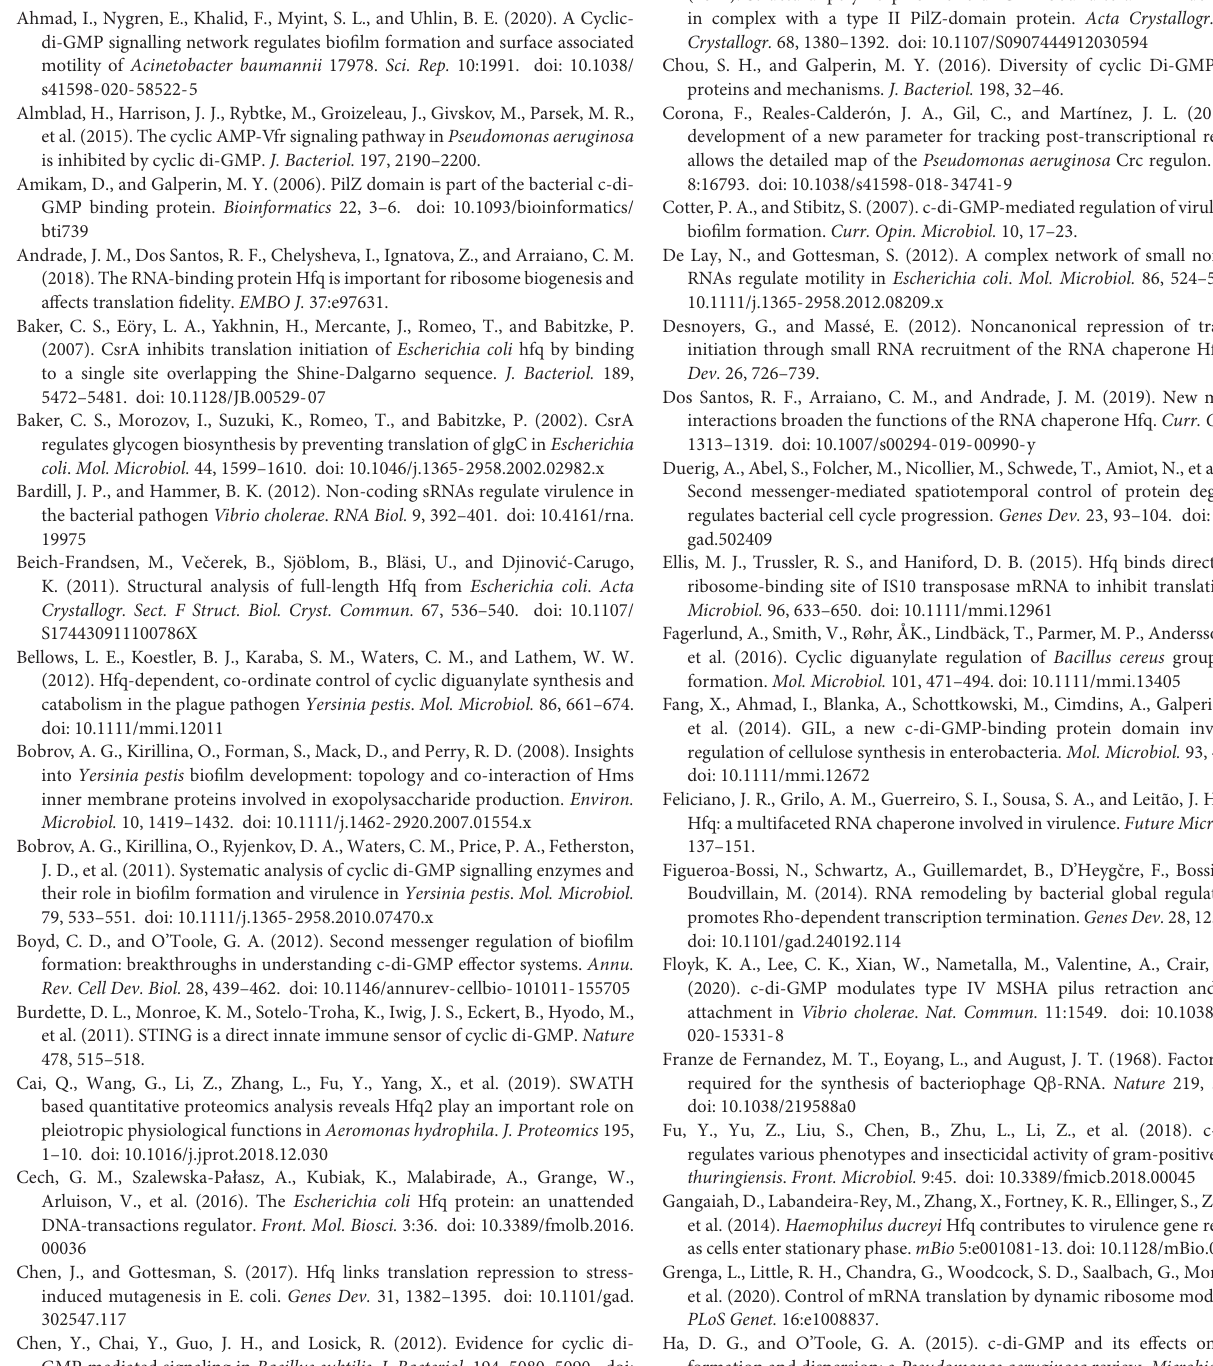
Figueroa-Bossi, N., Schwartz, A., Guillemardet, B., D’Heygˇcre, F., Bossi, L., and Boudvillain, M. (2014). RNA remodeling by bacterial global regulator